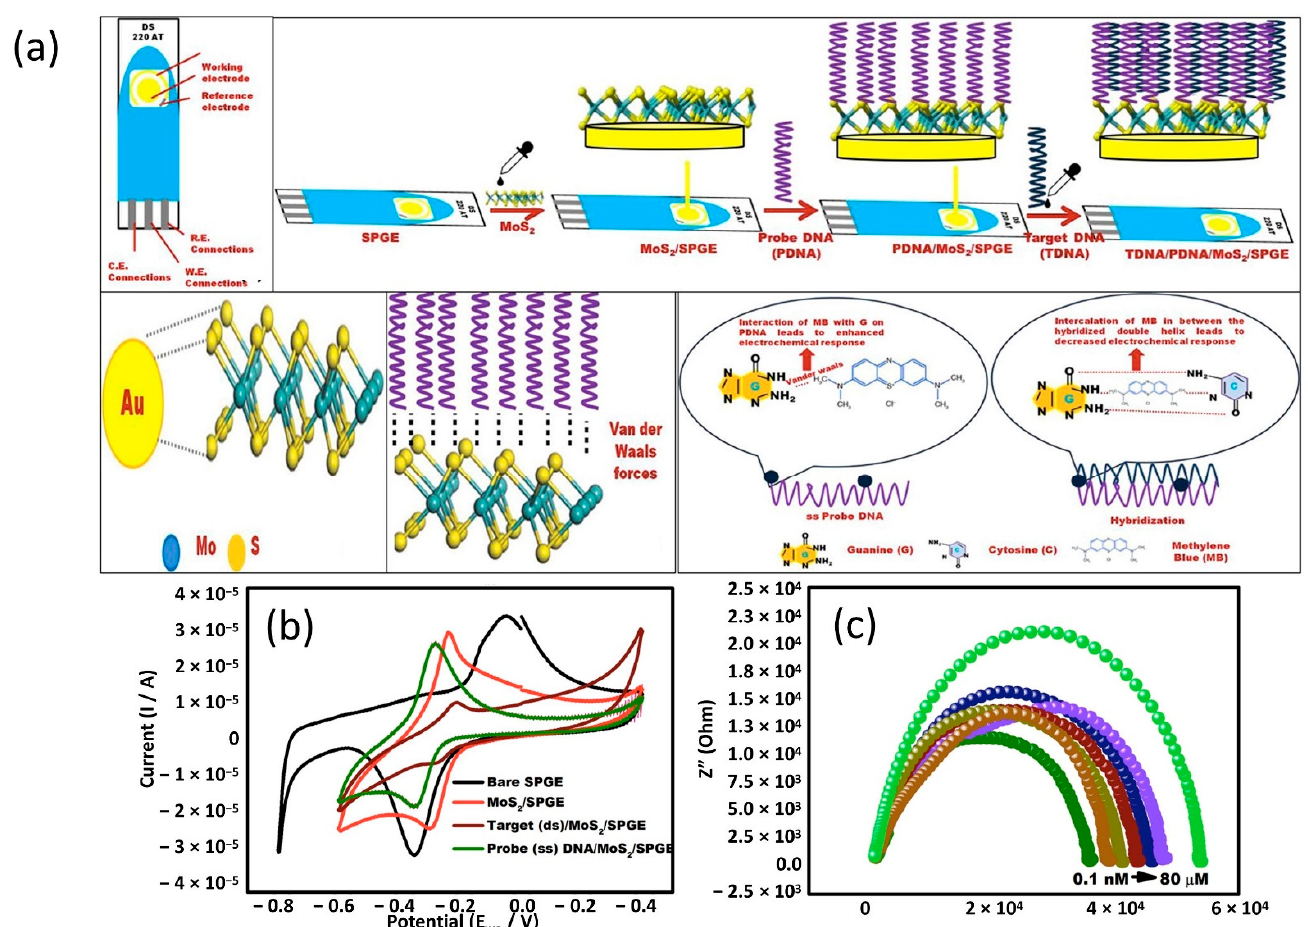
Figure 6. ( a ) From left to right, fabrication steps of MoS 2 /SPGE sensor for chikungunya virus. Stepwise shows fabrication of SPGE with MoS2 nanosheets, immobilization of probe DNA and target DNA. The next illustration shows strong affinity interaction of Au and S (in MoS 2 ), Van der Waals interaction between probe DNA and the MoS 2 surface, principle for the detection of target DNA via redox hybridization indicator, i.e., methylene blue. ( b ) Comparison of cyclic voltammetry graph of bare SPE, MoS 2 /SPE, Target/MoS 2 /SPE, and Probe/MoS 2 /SPE. ( c ) Nyquist Plot verifying hybridization of the different concentration of the complementary target DNA at PDNA/MoS 2 NSs/SPGE. Reprinted with permission from [133]. Copyright 2018 Springer Nature. Authors licensed under a Creative Commons Attribution (CC BY)